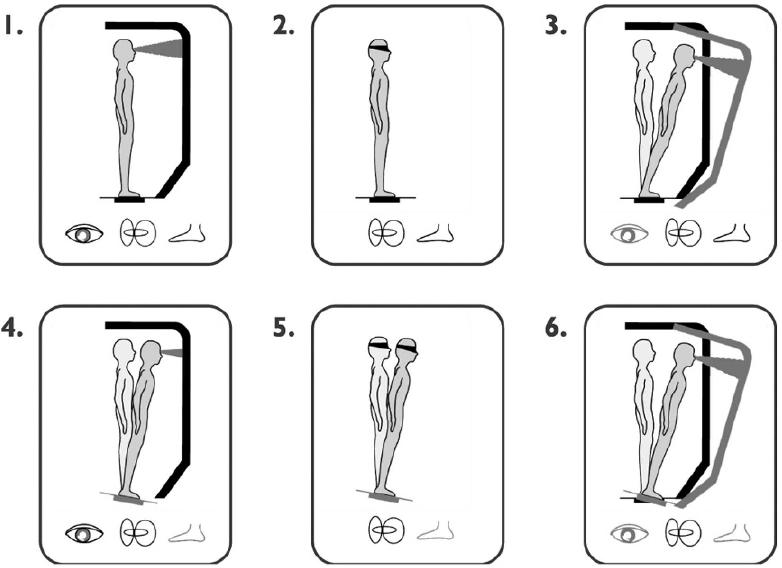
Figure 2 - The six test conditions of the Sensory Organization Test. Picture reprinted with permission from NeuroCom International TM